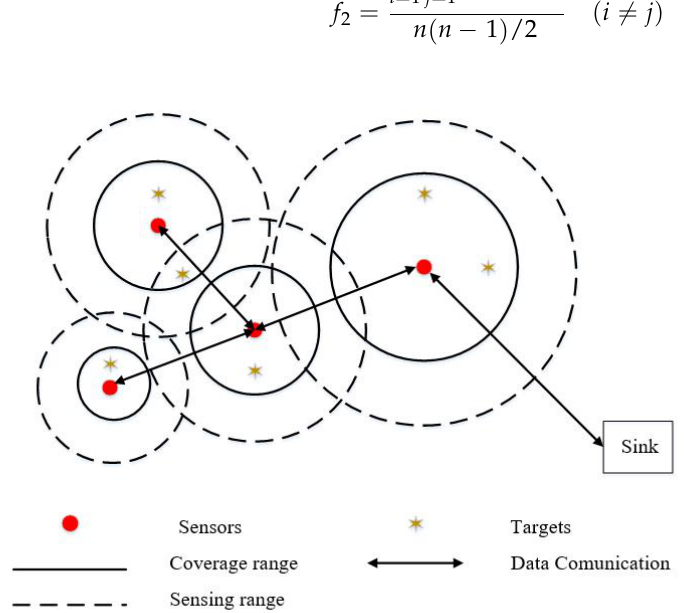
Figure 1. HWSN coverage model.